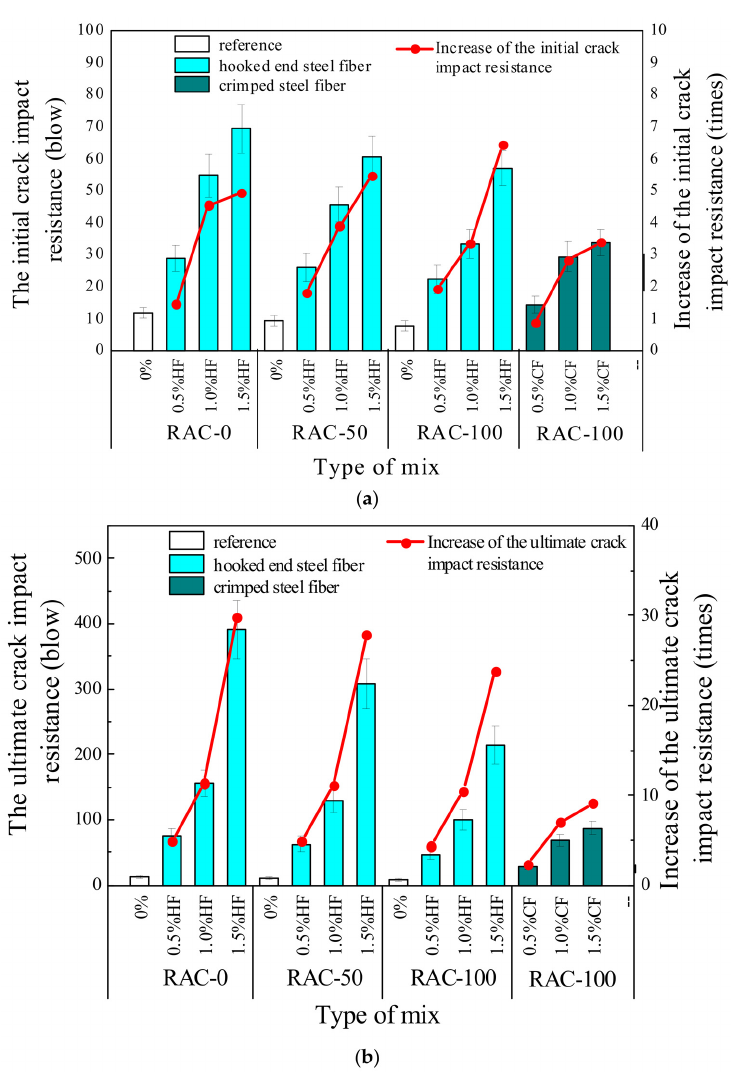
SD—standard deviation; COV—coefficient of variation.